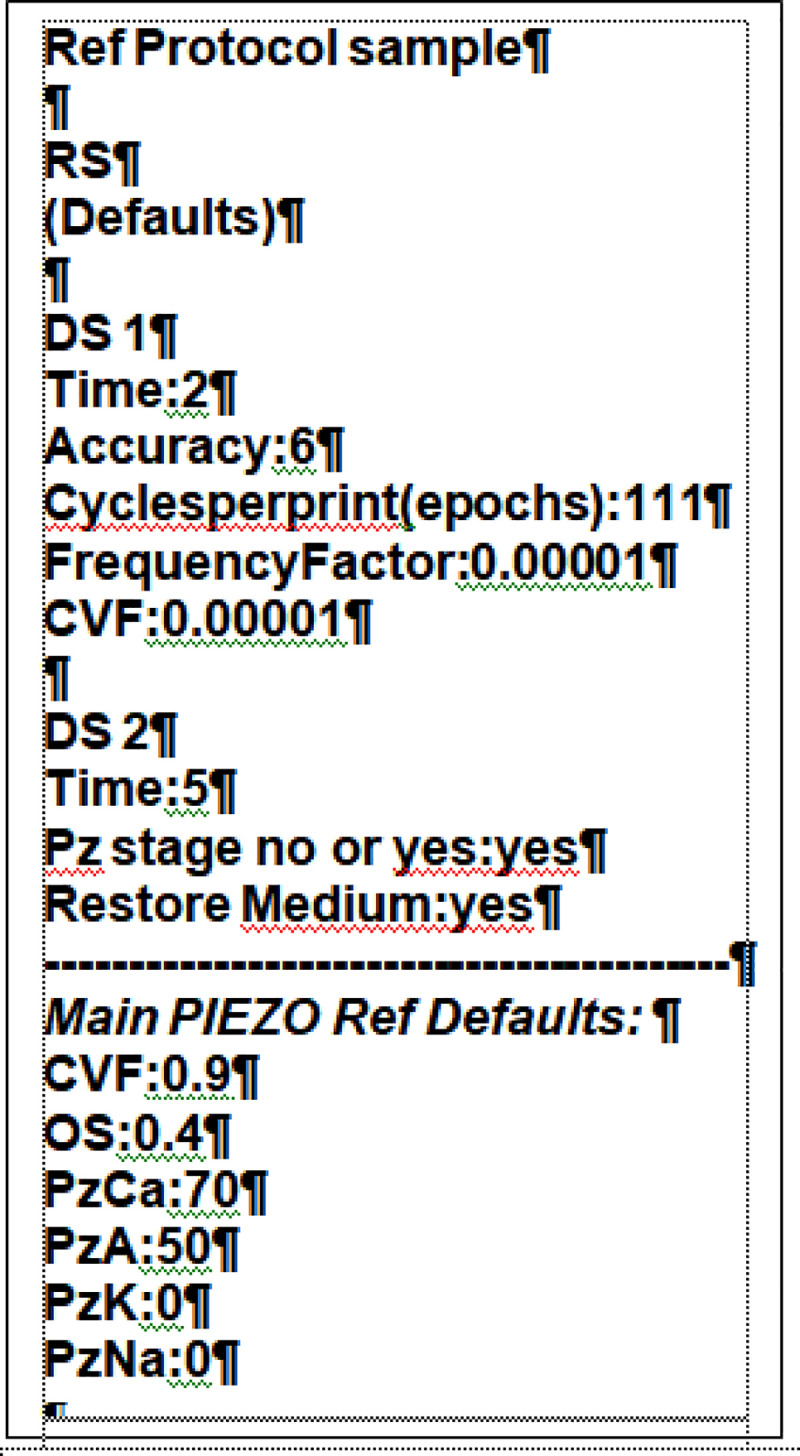
Default Reference protocol (Ref) for testing the effects of parameter and variable changes on RBC responses during and after capillary transits.The default protocol runs a three-step dynamic sequence on a RBC configured by the defaults in the Reference State (RS): DS1: a two minute baseline; DS2: a pre-programmed routine of two distinct stages; at t = 2min, ingress to a capillary, defined by an instant transition from a very low (CVF = 10−5) to a very high (CVF = 0.9) cell volume fraction together with opening of PIEZO1 channels for 0.4s; at t = 2min+0.4s, instant capillary egress simulated with a very low CVF (10−5), PIEZO1 inactivation and medium composition restored to baseline values. The default period of the post-transit stage was set to extend to 5min. Within the DS1 baseline period, we set the data output conditions to be followed through DS1 and DS2: “accuracy” was set to 6, the minimal value found to be required for reporting the miniscule size of the predicted changes; “Epochs” was set to 111 and “Frequency factor” to 10−5, values found to offer acceptable point densities in the model outcomes for discerning predicted time-dependent trends unambiguously. For the DS2 period covering the brief capillary transit and subsequent relaxation period back in the systemic circulation, we start by setting the overall duration of this stage (5min in the Ref sample) and then bring up the dedicated PIEZO routine confirming with “yes” the prompts on “Pz stage no or yes” and on “Restore Medium”. All defaults are open to change as extensively implemented for Figs 3 and 5.